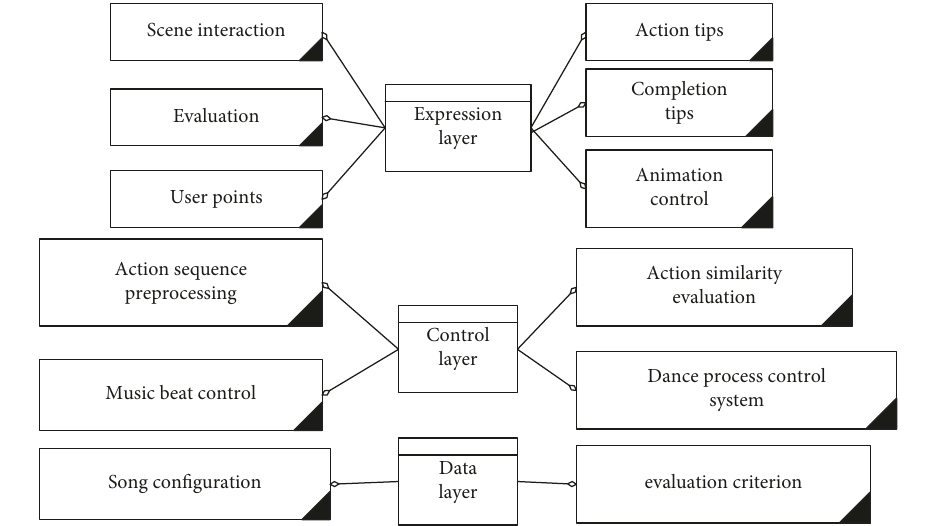
Figure 14: System structure diagram.